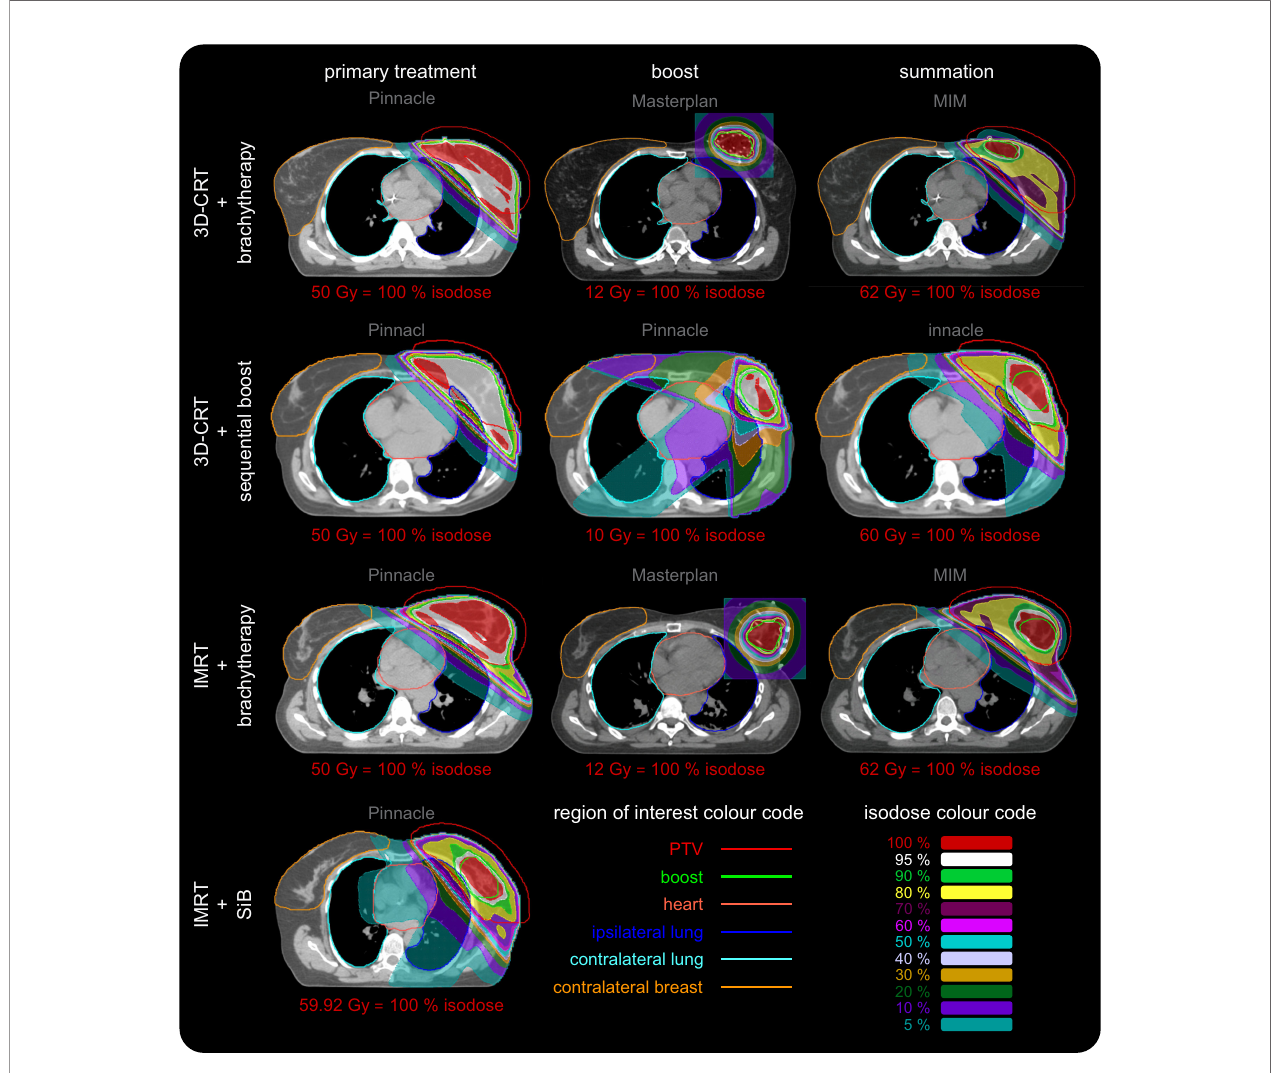
FIGURE 5 | Representative dose distributions of all four regarded scenarios for primary treatment, boost, and their summation. The dose distributions were calculated using Philips Pinnacle and Oncentra Masterplan. The screenshots were made in Pinnacle and MIM. The colour codes of the regions of interest and isodose curves are depicted in the lower right corner. The corresponding dose value of the red 100% isodose is given for each image separately. Each row depicts a different scenario. The columns represent the primary treatment (dose calculation in Pinnacle, left column), the additional boost (dose calculation in Pinnacle and Masterplan, centre column) and their summation (Pinnacle and MIM, right column). The scenario “ IMRT + SiB ” only has one column since this concept utilises an integrated boost. We use the software prede fi ned windowing “ breast ” (Pinnacle) and “ mediastinal ” (MIM) to illustrate the local Houns fi eld units or mass density distribution, respectively, as a grayscale. The brachytherapy CT image used to calculate the dose in Masterplan is presented after the deformed registration in MIM. The dose summation is shown without taking into account the BED in order to maintain visual comparability of all scenarios since “ 3D CRT + sequential boost ” and “ IMRT + SiB ” do not show BED summation as well. In the latter case, direct comparability is not possible since the fractionation schemes are combined into one concept. The various OARs are highlighted as contours: the PTV (red line), the boost volume (green line), the heart (light red line), the left and the right lung (blue and teal line), and the contralateral breast (orange line). The dose distributions are depicted as coloured areas. See inset in the lower right corner for the colour code of the isodoses. The colour scale is normalised to the respective prescribed dose of each case and given below each image. The required minimum target volume coverage (PTV or boost) for clinical acceptance is at least 95 % (white areas), which is ful fi lled for all primary WBI and boost treatments. Usually the lowest isodose scale is chosen to be 10 %. We also show the 5 % isodose area to visualise an approximation to the low-dose regime (additional scattering effects are not included) relevant for secondary cancer risk calculation and affected OARs in this respect: the heart, the ipsilateral and contralateral lung and the contralateral